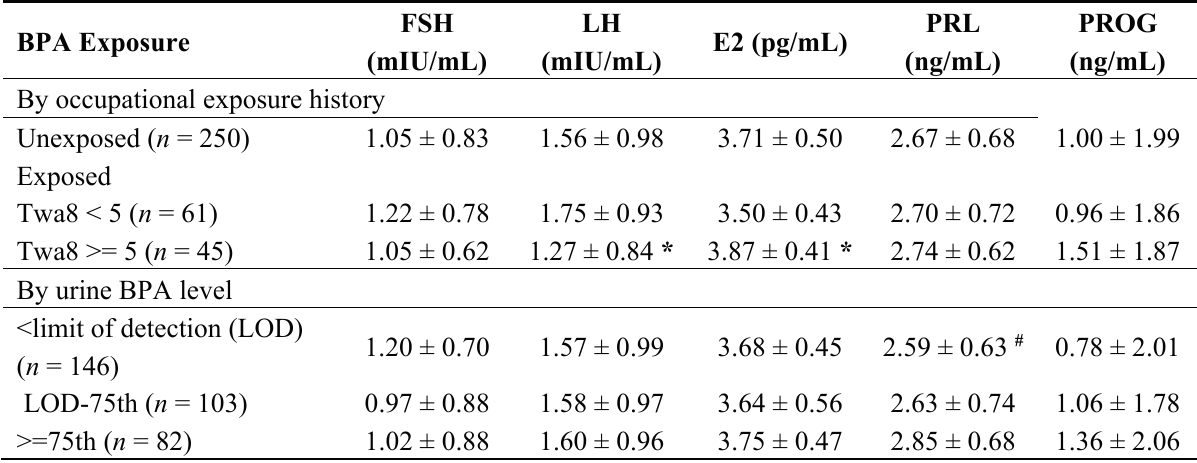
Table 2. Average hormone levels by BPA exposure (mean ± std, log-transformed).